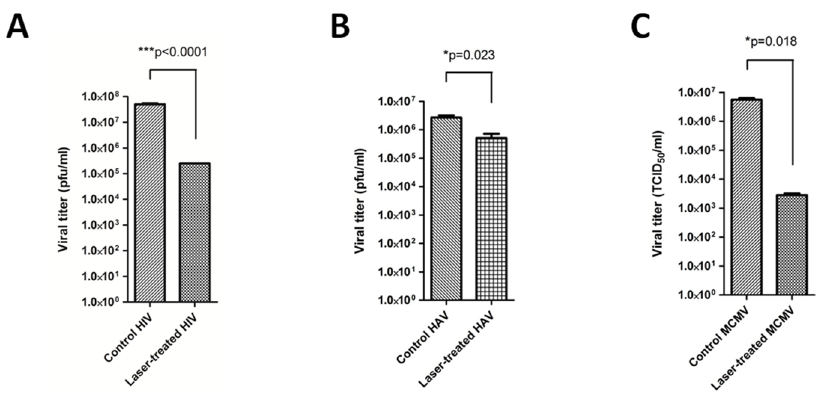
Figure 1. Inactivation of viruses in plasma using a USP laser. Human plasma containing HIV (A), HAV (B), or MCMV (C) were treated with the USP laser. For the HIV-spiked plasma, viral titer was assessed by plaque assay in MAGI cells. For the HAV-spiked plasma, viral titer was assessed by plaque assay in fetal rhesus monkey kidney cells. For the MCMV-spiked plasma, viral titer was assessed by TCID 50 assay in murine embryonic fibroblast cells. Results are representative of triplicate experiments and are shown as means 6 SEM.